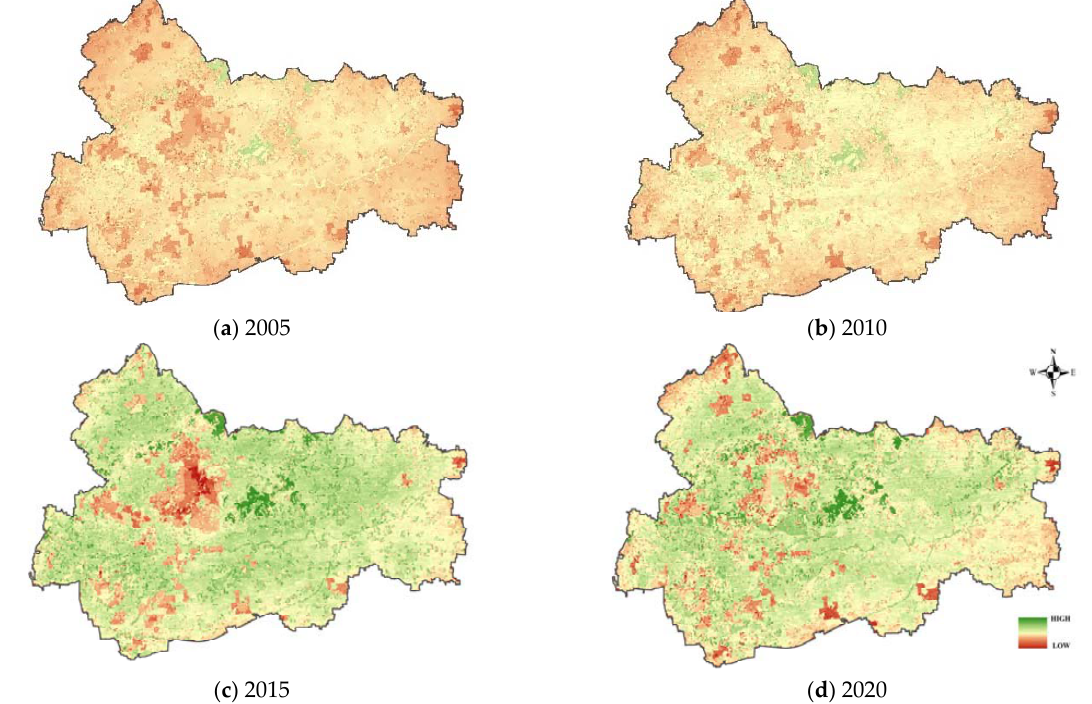
Figure 7. Overall change in regional landscape multifunctionality level from 2005 to 2020.